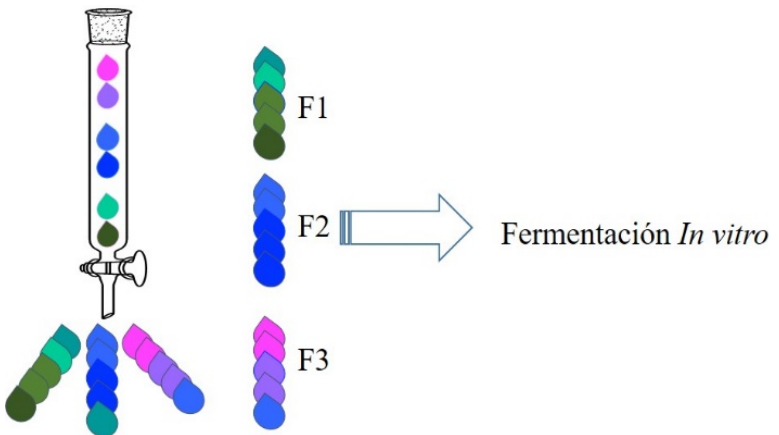
Figure 1. Scheme of fractionation of prehydrolysate fraction.